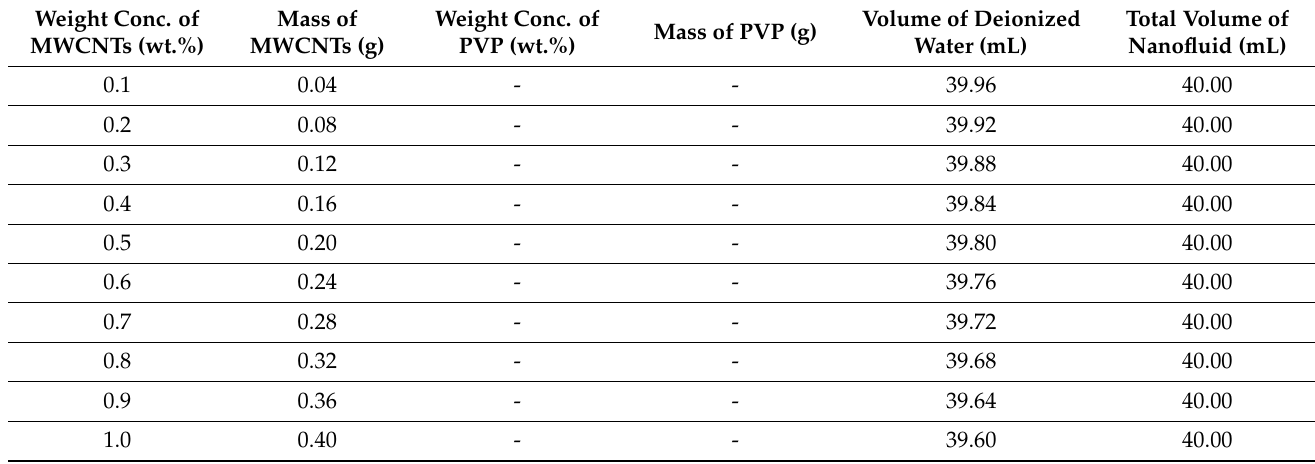
Table 3. Nanofluids formulation using commercial and modified MWCNTs without